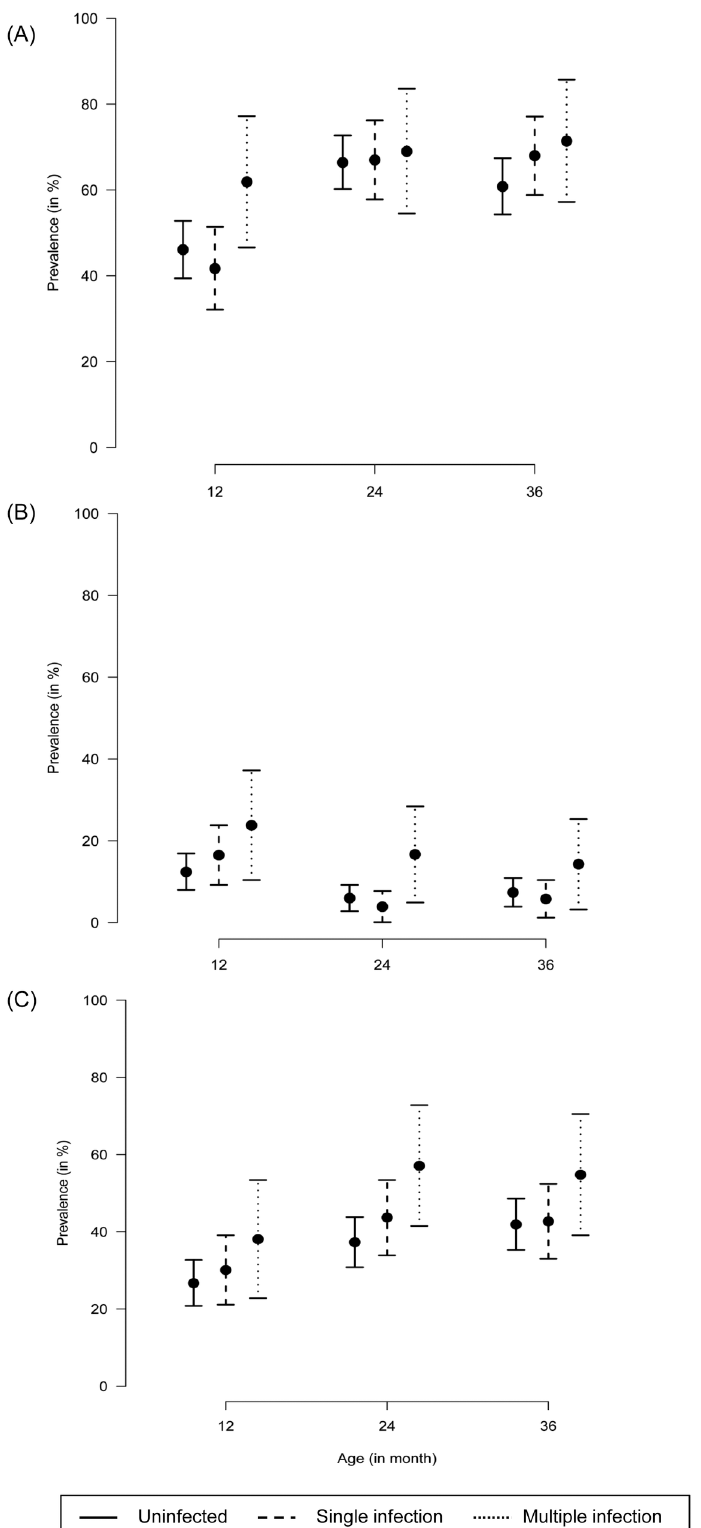
Fig 3. Proportion (with 95% CI) of (A) stunted, (B) wasted and (C) underweight children at 12, 24 and 36 months of age. The y-axis depicts the proportion of children with growth deficiency whereas the x-axis represents age in months. The point prevalence is presented as a circle and the 95% CI is represented as